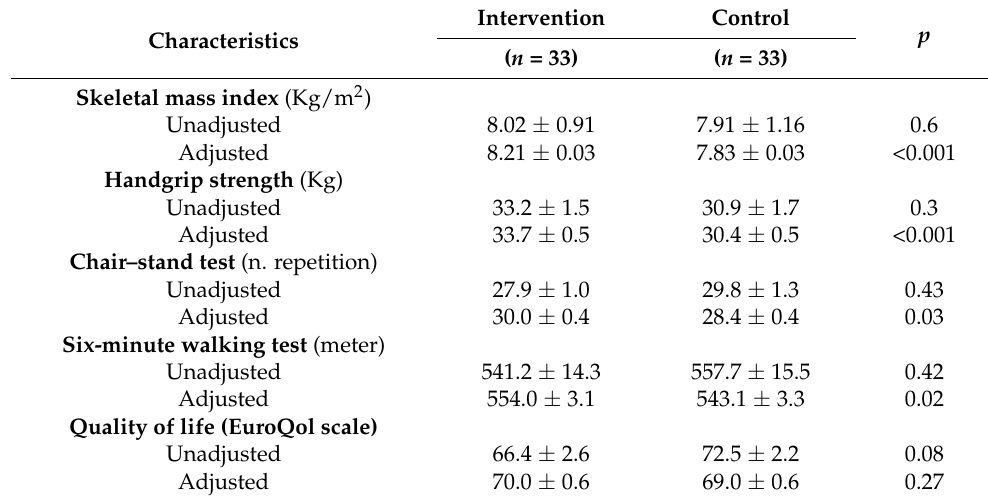
Table 3. Unadjusted and adjusted means of skeletal muscle index and physical performances measures (dependent variables) according to treatment after 8 weeks of observation.